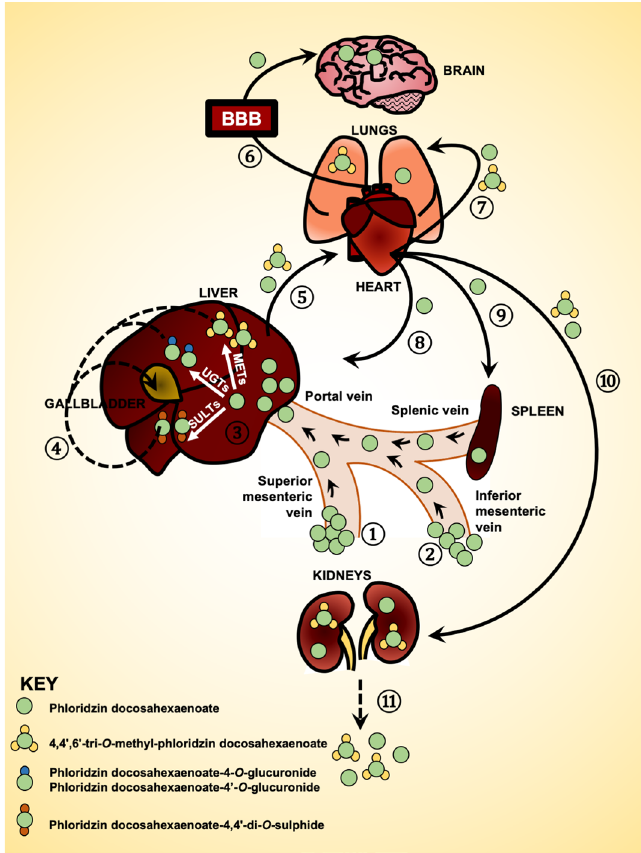
Figure 6. Proposed scheme for the fate of PZ-DHA upon intraperitoneal administration into Balb/c female mice. Absorption of intraperitoneally administered PZ-DHA via ① superior mesenteric vein and ② inferior mesenteric vein; ③ Phase II metabolism of PZ-DHA in the liver; ④ Biliary secretion and entero-hepatic circulation of PZ-DHA and its metabolites; Distribution of PZ-DHA and its metabolites via ⑤ inferior vena cava, ⑥ left and right carotid arteries, ⑦ bronchial arteries branched from the descending aorta; ⑧ hepatic artery branched from descending aorta, ⑨ splenic artery, and ⑩ renal arteries branched from descending aorta; ⑪ PZ-DHA may be excreted via kidneys. Solid-lined arrows ( → ) indicate confirmed processes and dashed-line arrows ( ⇢ ) indicate suggested potential processes, which need to be confirmed in future studies. BBB blood brain barrier; METs methyltransferases; UGTs UDP-glucuronosyltransferase; SULTs